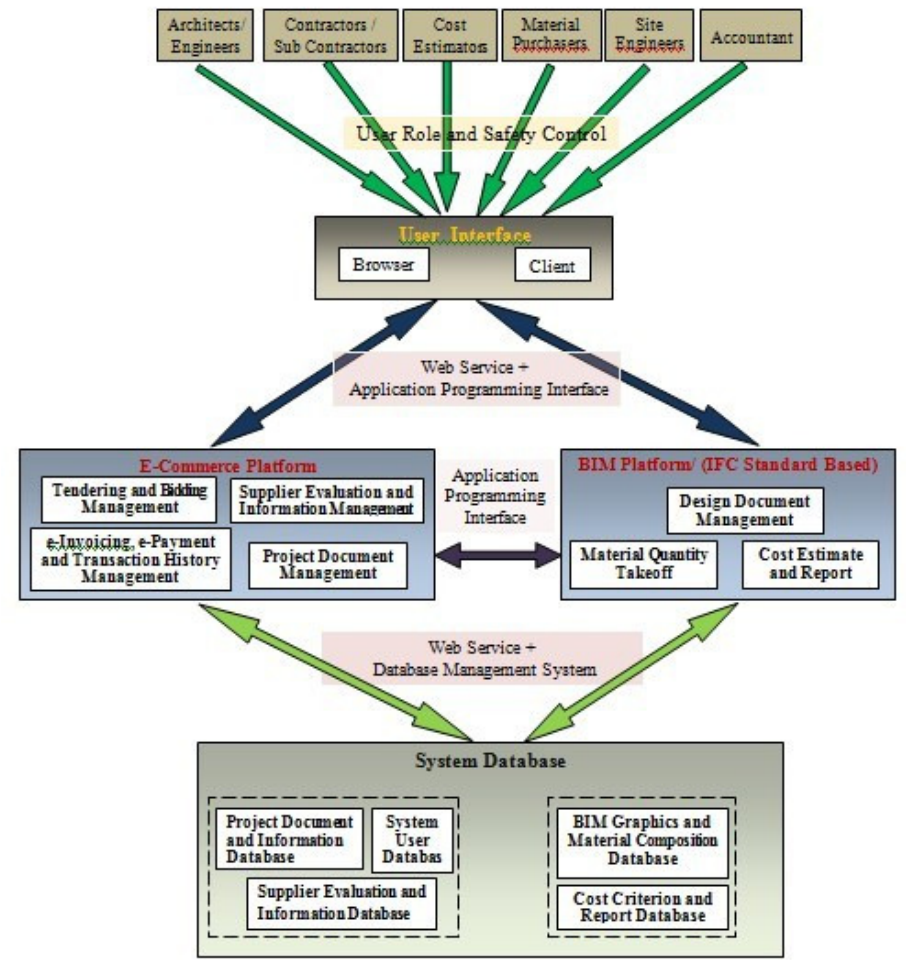
Fig. 6. BIM integrated with e-commerce software system